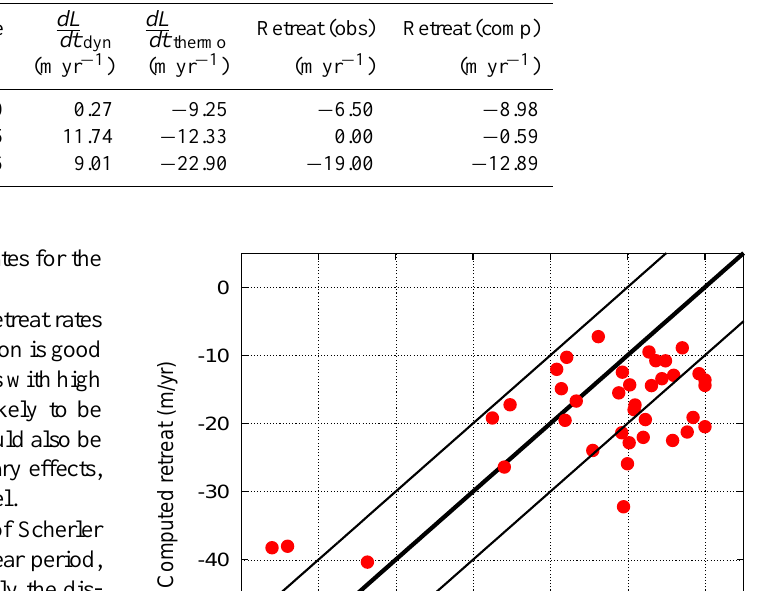
Table 3. Computed and observed retreats for the fitted set. RMS error is 1.61myr − 1 . dL Glacier Length Slope dL Retreat (obs) Retreat (comp) dt dyn dt thermo (km) (myr − 1 ) (myr − 1 ) (myr − 1 ) (myr − 1 ) Hamtah 7.0 0.102 1.46 − 16.32 − 16.00 − 14.86 Ch-Shigri 9.0 0.140 2.52 Satopanth − 2.20